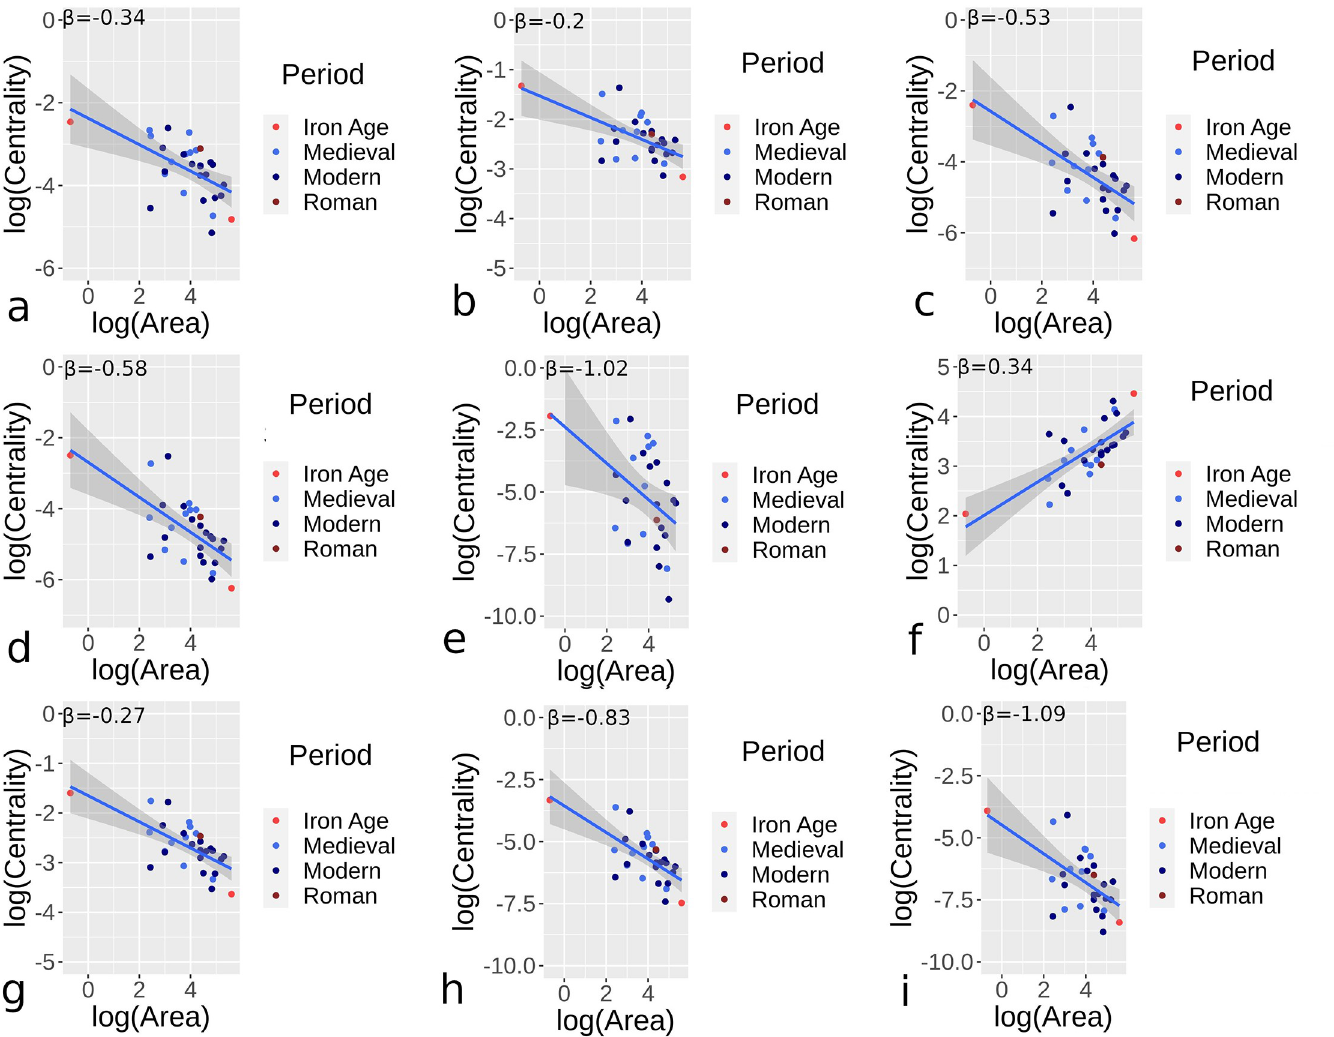
Fig 8. Centrality and area scaling values for urban settings in different periods and for all nearly complete or complete street networks for hybrid/organic street networks. Results demonstrate betweenness (a), closeness (b), degree (c), efficiency (d), eigenvector (e), harmonic (f), Katz (g), straightness (h), and current flow (i) centrality